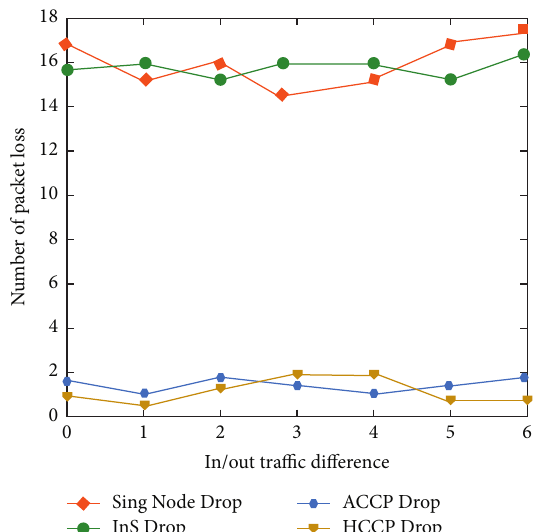
Figure 5: Different situations of the cache